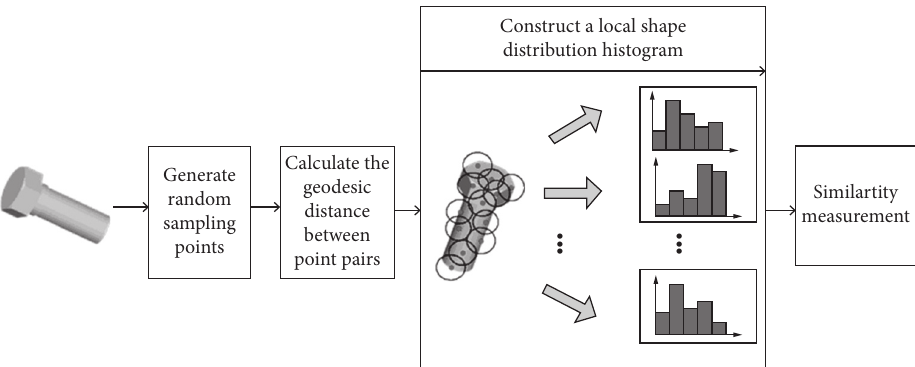
Figure 6: The overall idea of the garden landscape perspective distance-angle shape distribution analysis algorithm based on the 3D CAD model retrieval